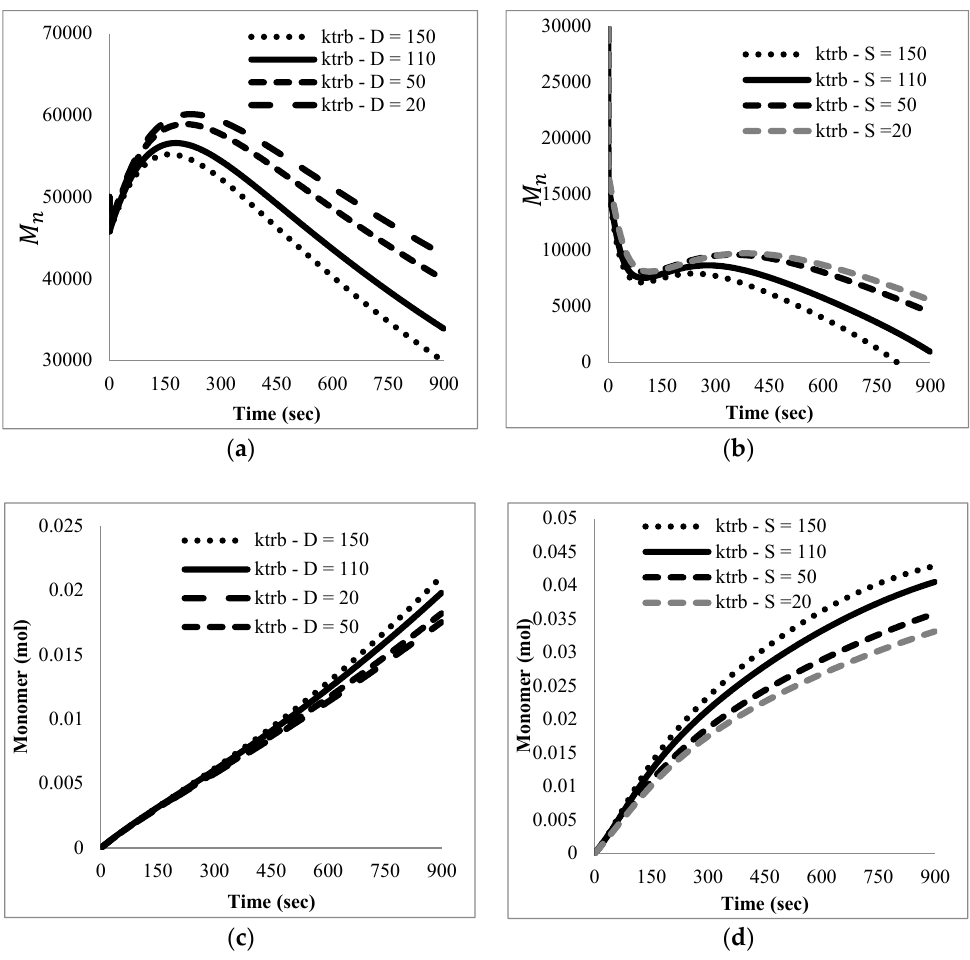
Figure 8. Effect of the variation of transfer to polymer + β -scission ( k trb ) values on the pyrolysis M n evolution of ( a ) dead polymer and ( b ) dormant polymer, and on the monomer generation of ( c ) dead polymer and ( d ) dormant polymer.